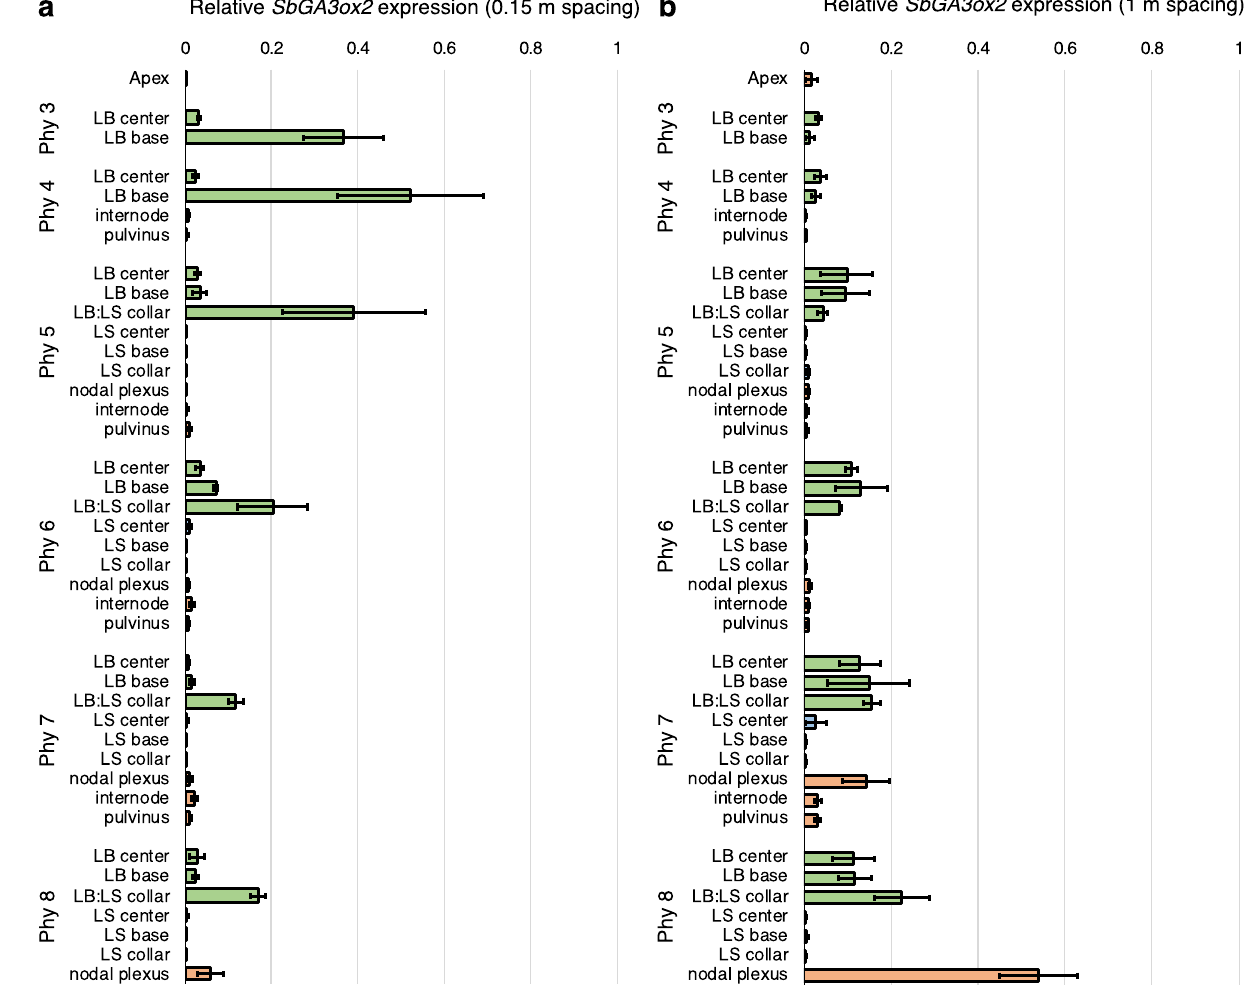
Figure 5. Relative expression of SbGA3ox2 in sorghum grown at 0.15 m ( a ) and 1 m ( b ) spacing. Tissues were collected from the shoot apex (Apex), mid leaf blade (LB center), base of the leaf blade (LB base), tissue between the leaf blade and leaf sheath (LB:LS collar), mid leaf sheath (LS center), base of the leaf sheath (LS base), leaf sheath collar (LS collar), stem nodal plexus, internode, and pulvinus of phytomers (Phy) 3–8. Relative expression is shown in bar graphs (leaf blade = green, leaf sheath = blue, stem = brown). Expression values are the average of three biological replicates. Error bars: SEM. Photograph and diagram of the development of sorghum phytomer tissues is shown in Supplementary Figure